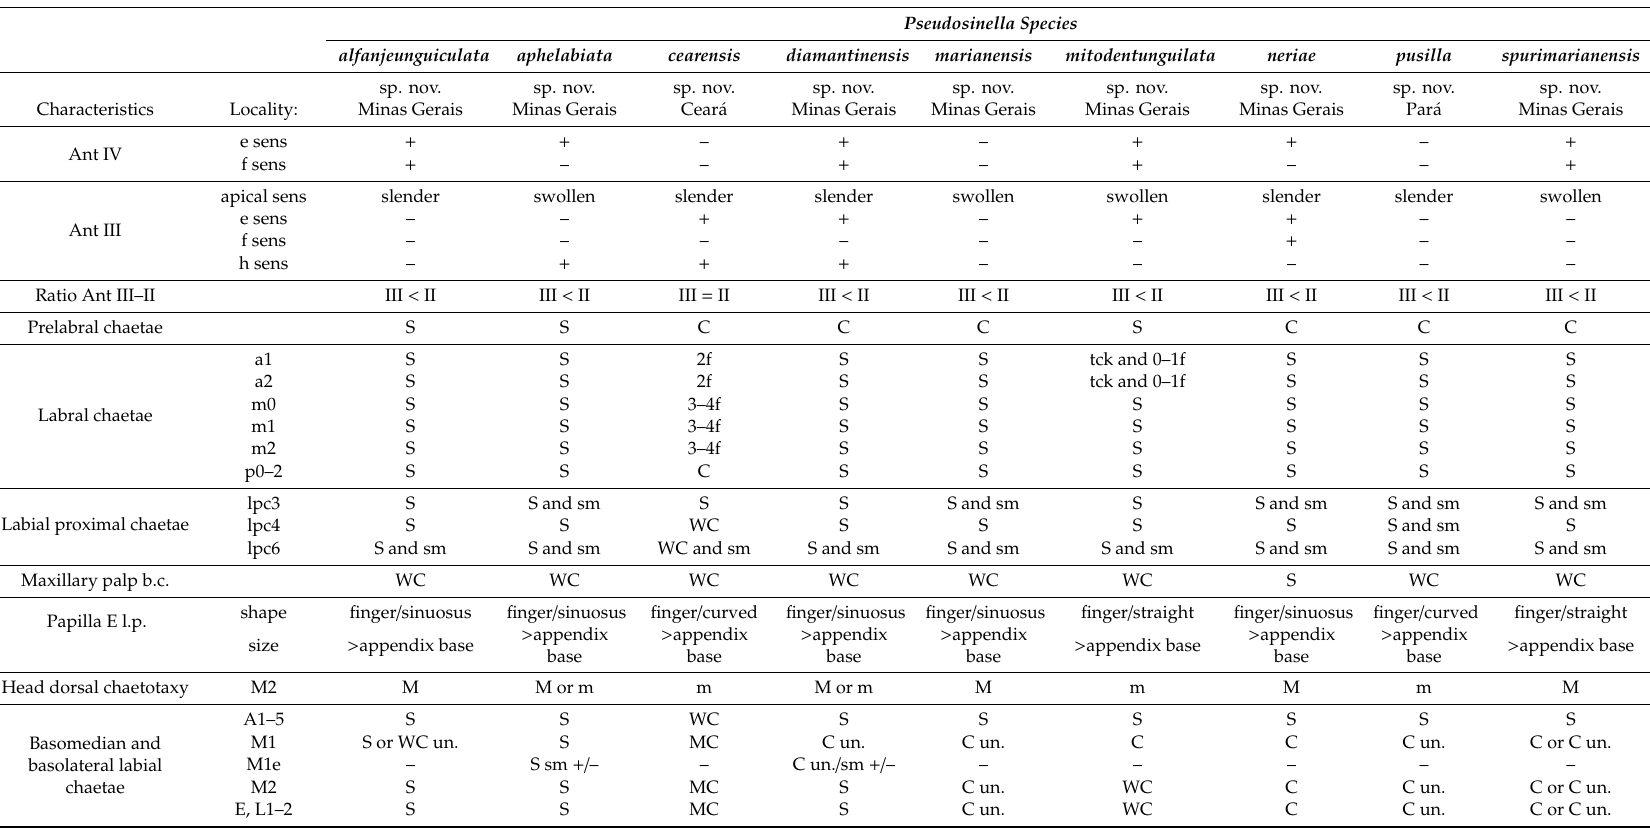
Table 5. Comparison (per side) among new species of Pseudosinella from Brazil with prelabral chaetae undivided (normal), unguiculus pe lamella toothless, basomedian labial field with r chaeta reduced, Abd II with m3 and m5 mac, Abd II with pm6 and p6 mac, furcula only with ciliate chaetae, devoid of pigments, eyes and apical bulb on Ant IV.